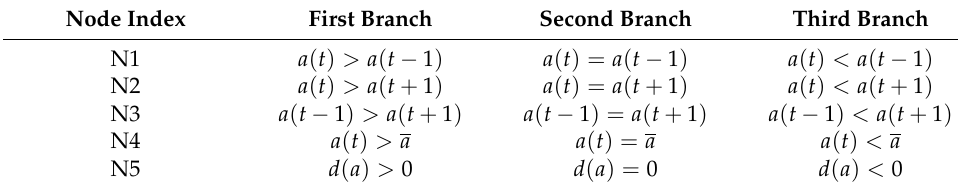
Table 1. Originally designed branch nodes of five